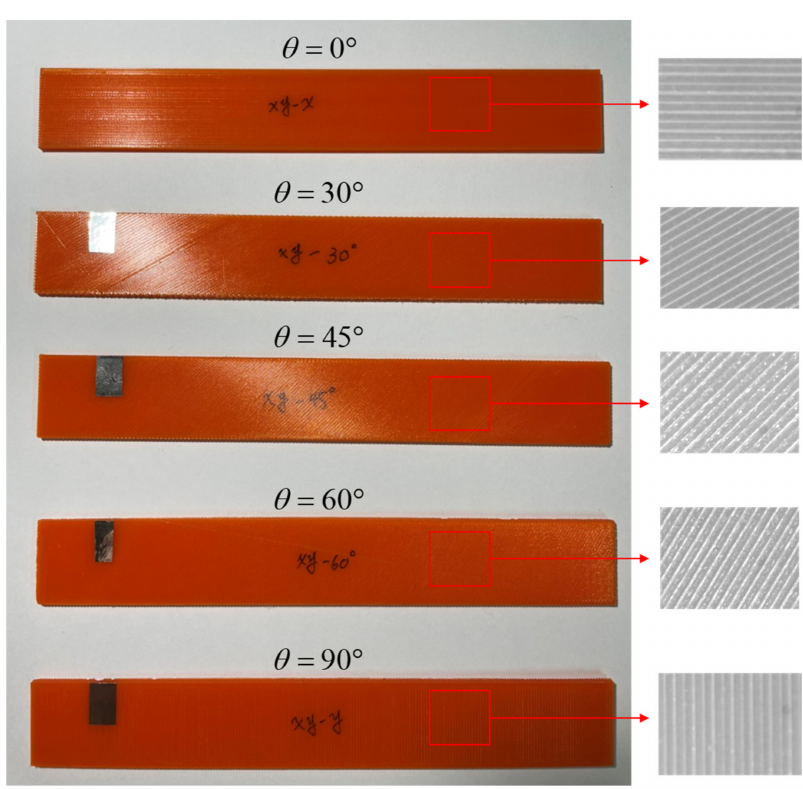
Figure 8. Photos of test pieces with different raster